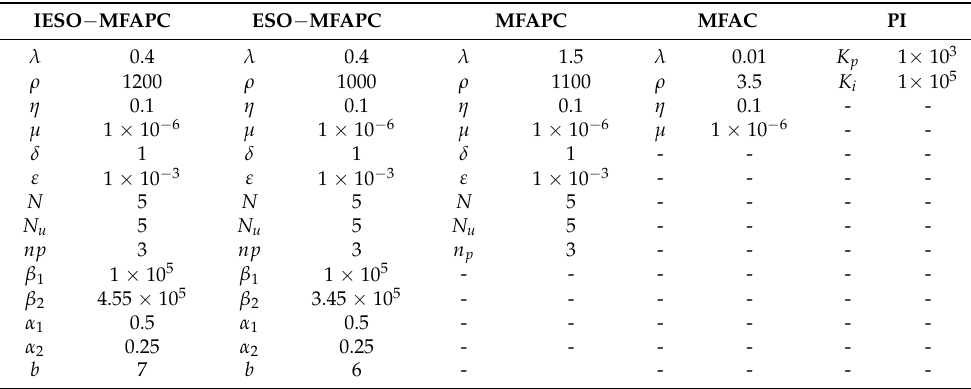
Table 2. Parameters of the four control algorithms.